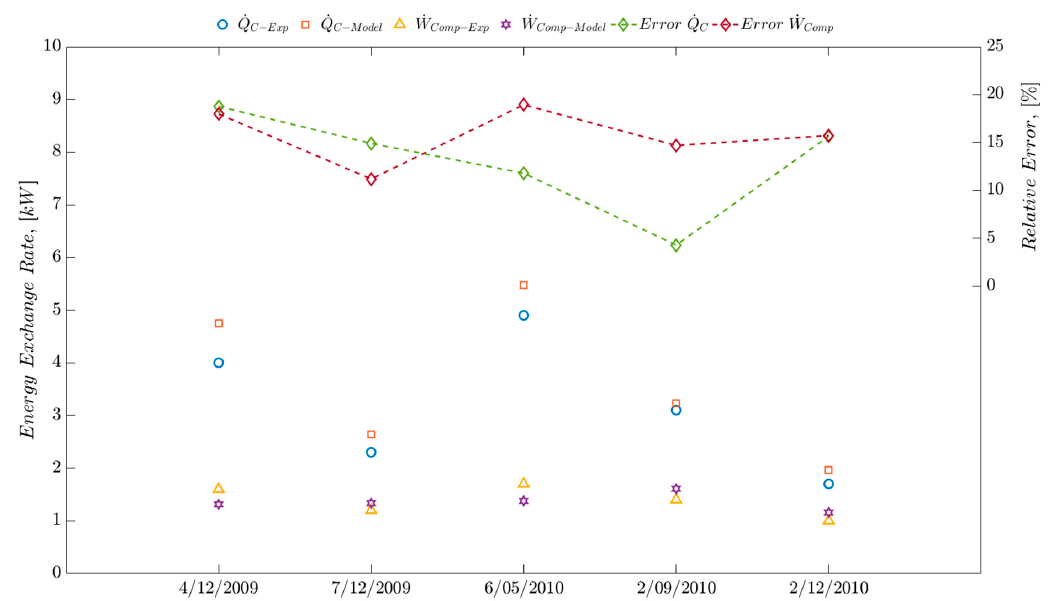
Figure 5. Comparison with experimental data provided by Moreno-Rodriguez [51].